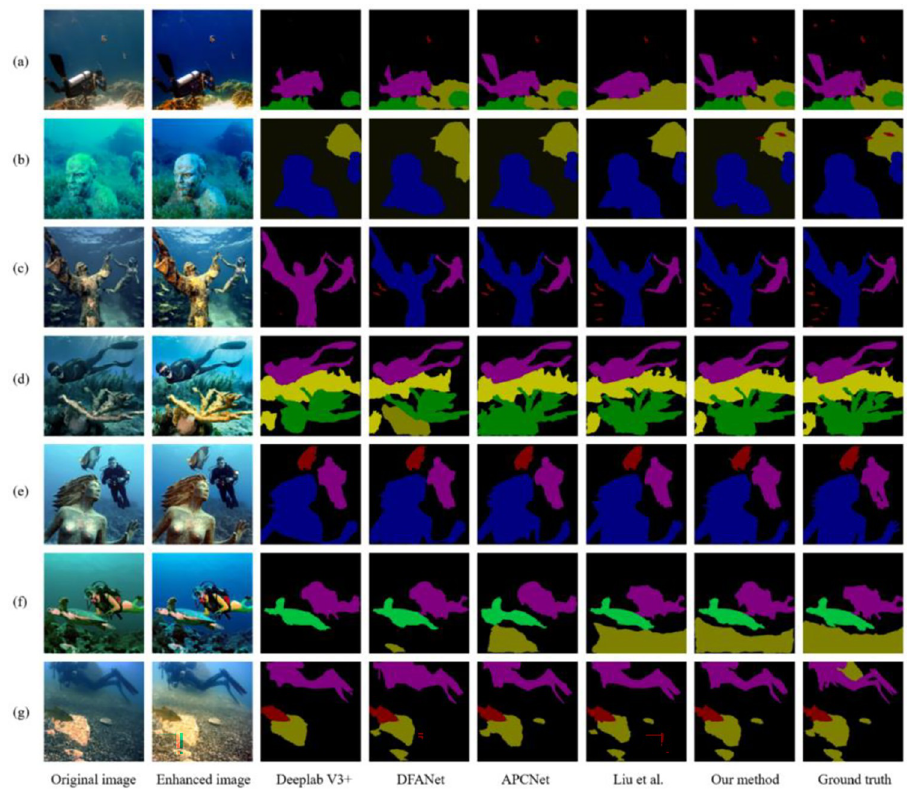
Fig 11. Qualitative comparisons on clear underwater images. From left to right are the original images, the enhanced images, and the results generated by Deeplab V3+, DFANet, APCNet, the method proposed by Liu et al., our method, and the ground